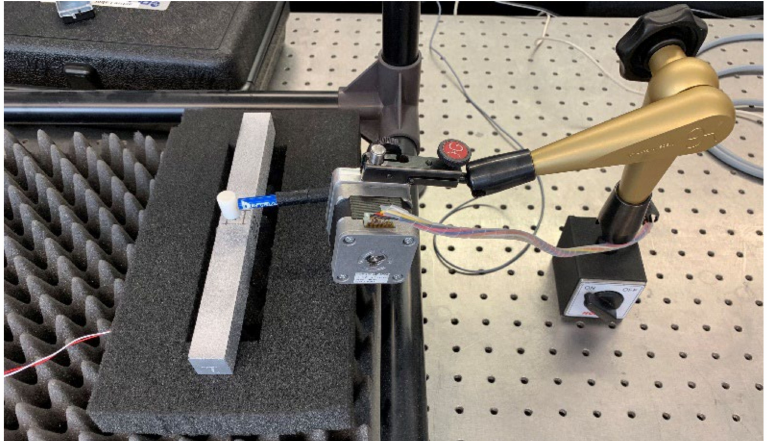
Figure 6. Test setup for the characterization of particle damping, reprinted with permission from ref. [7]. Copyright Elsevier.